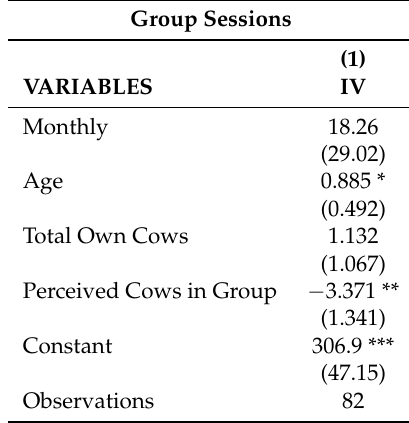
Table 9. Effect of Perceived Farm Size on the Amount of Insurance Purchased in Groups.